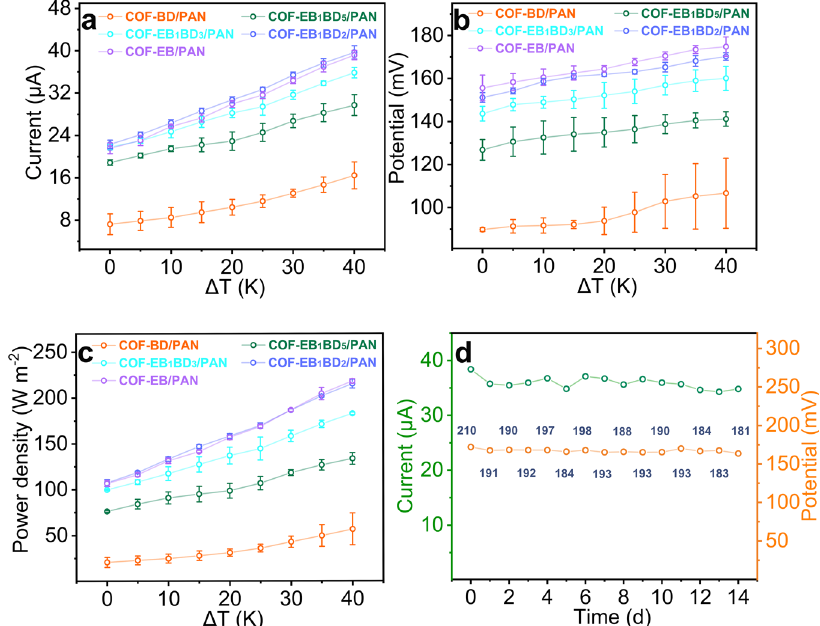
Fig. 6 Evaluation of thermo-osmotic conversion performance and long-term stability of COF-EB x BD y /PAN. a – c Variations of V oc ; I sc ; and output power density of COF-EB x BD y /PAN in response to the introduced temperature differences (the initial system was set as 298 K); the error bars represent the standard deviation of three independent measurements of the various membranes. Error bars represent standard deviation of three different measurements. d Plots of V oc ; I sc ; and output power density of the thermo-osmotic conversion device over